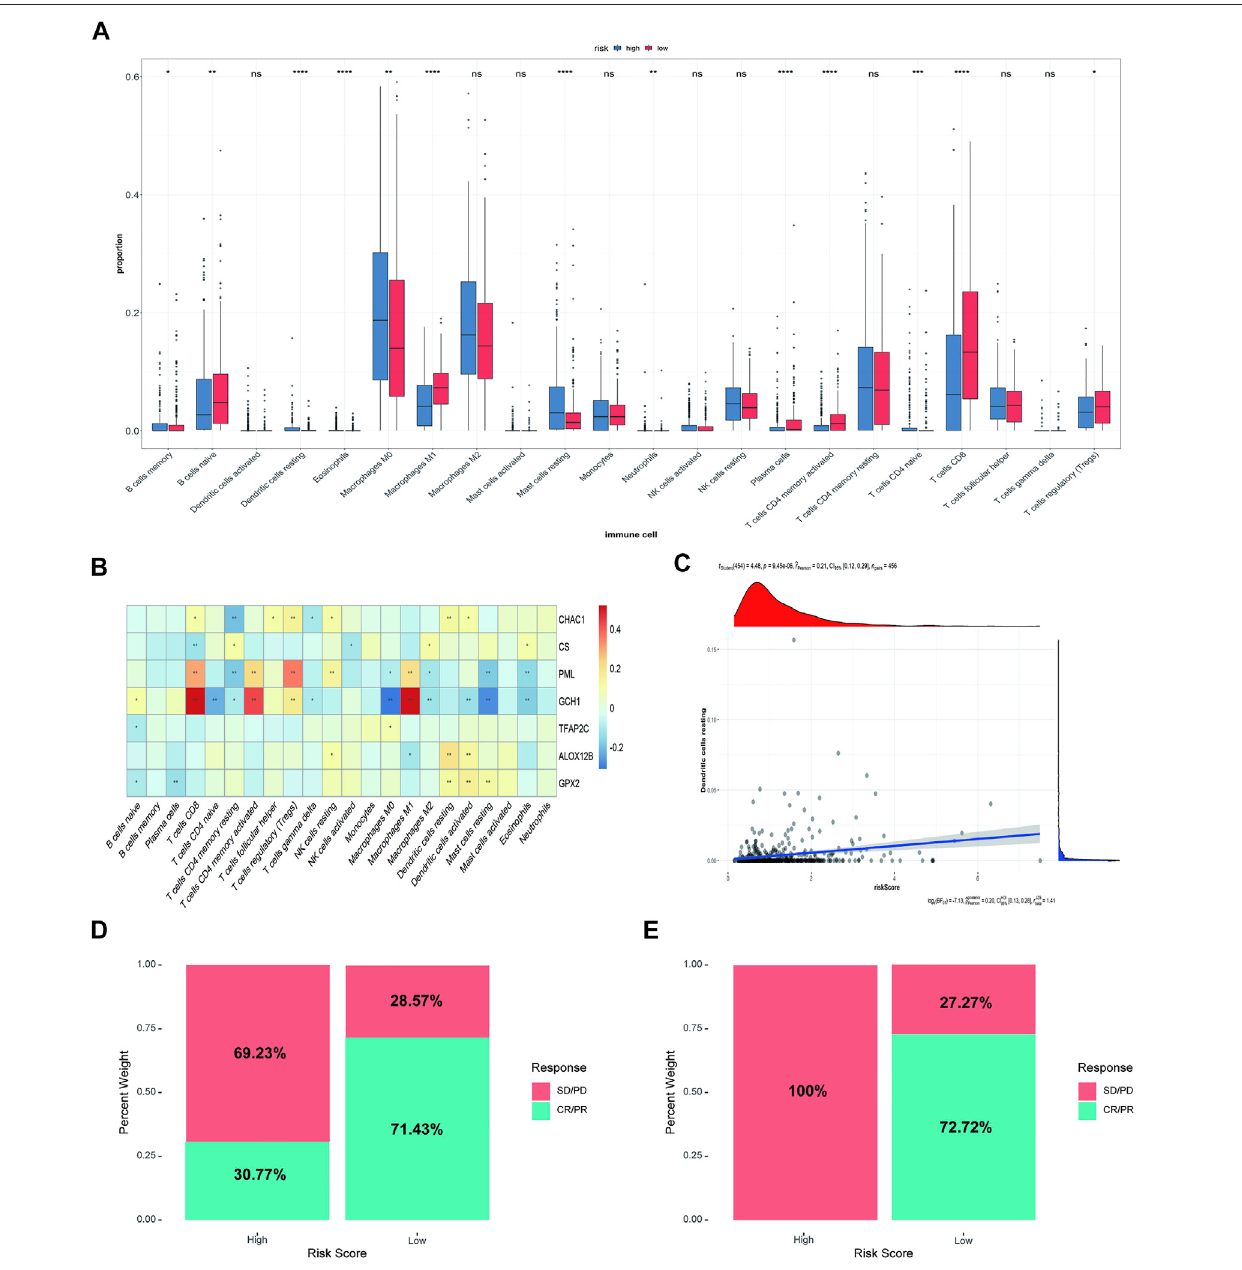
FIGURE5| Immunecorrelation analysisbetweenhigh-risk and low-riskgroups andComparison ofrickscoresandchemotherapy drugtherapeuticeffect. (A) The immunein fi ltrationanalysisbetweenriskgroups. (B) Thecorrelationanalysisbetweenimmunecellsand8ferroptosis-relatedgenes(ns:notsigni fi cant,*: p ≤ 0.05,**: p ≤ 0.01; ***: p ≤ 0.001). (C) The correlation analysis between risk score and dendritic cells. (D) The distribution of the drug response of samples in the high-risk group and low-risk group in GSE78220 cohort. (E) The distribution of the drug response of samples in the high-risk group and low-risk group in MSKCC